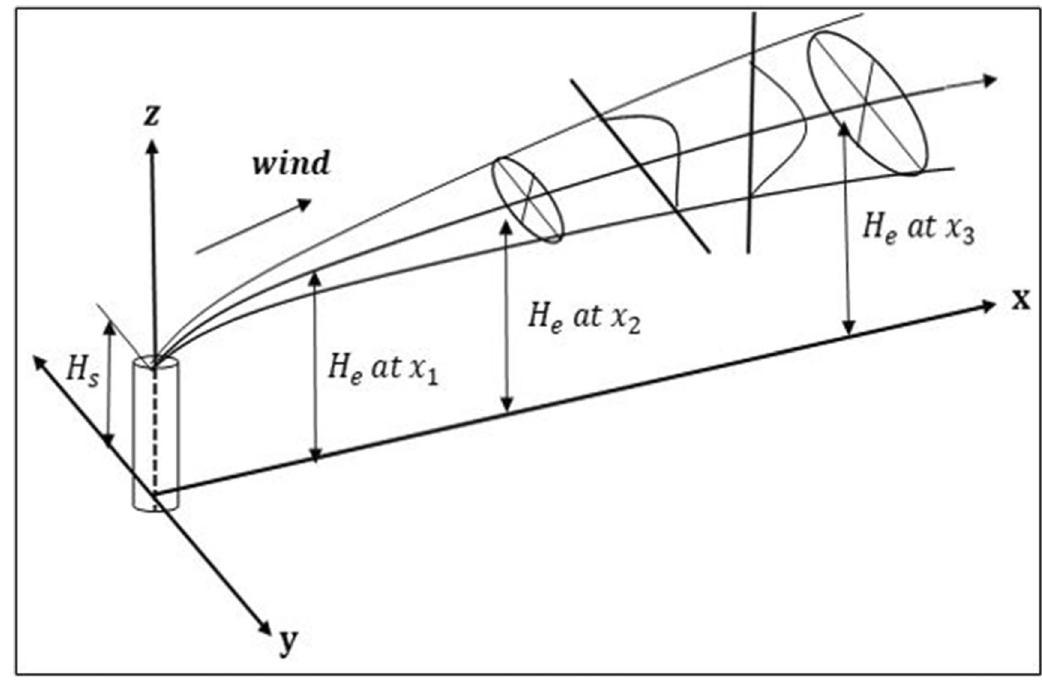
Figure 5. Gaussian dispersion model 13 .